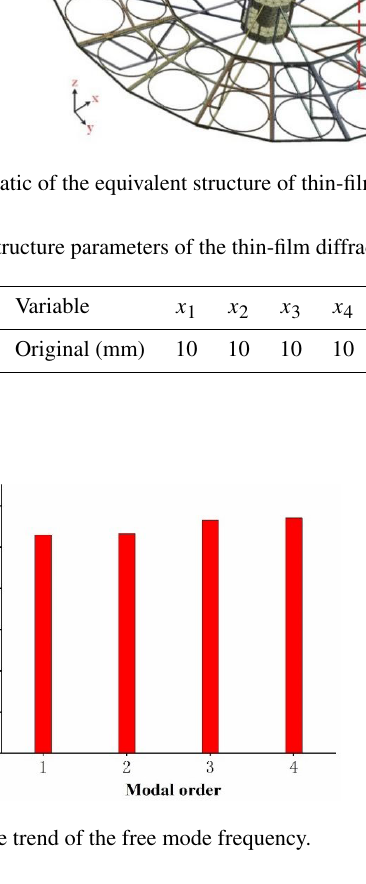
Figure 9. Second-order mode shape of free vibration.